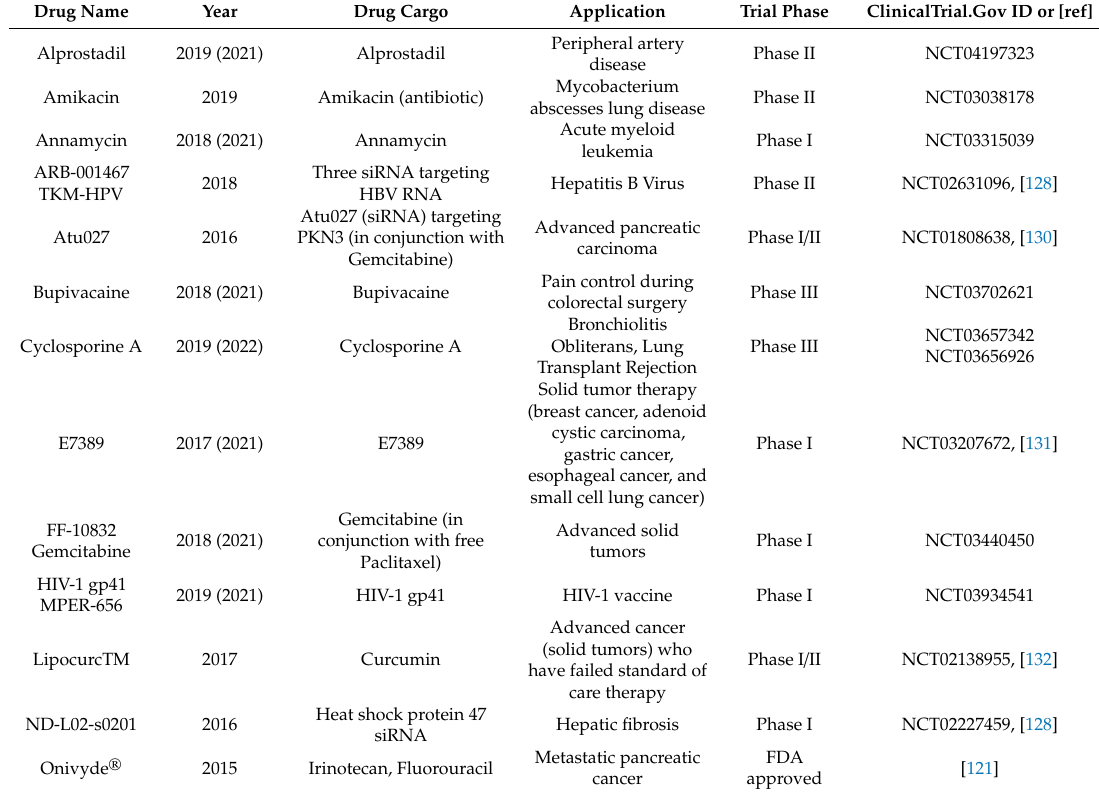
Table 2. Liposome-based drug therapies in clinical trials or recently approved for